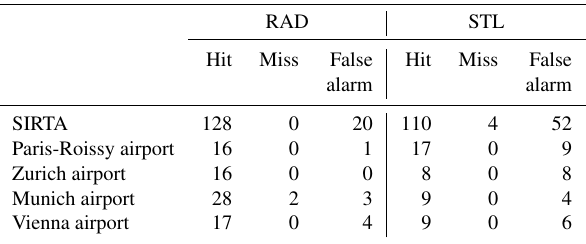
Figure 9. PARAFOG scores for (a) radiation and (b) stratus lower- ing fog events for the SIRTA and EU sites. The hatched bars corre- spond to the scores obtained with PARAFOG v1. Table 3. Results of the contingency table for both RAD and STL modules at the different